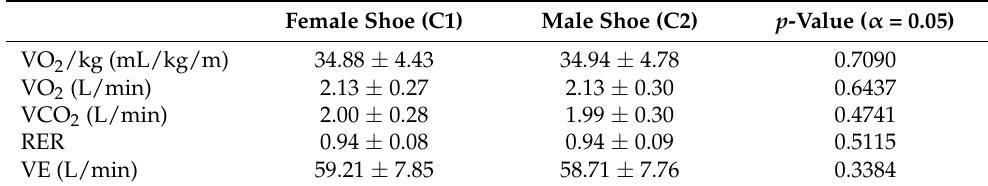
Table 2. Table showing the comparison of VO 2 , gas exchange, RER, and VE between shoe conditions. Data are presented as mean ± standard deviation with their associated p -values from the paired t -test ( α = 0.05).